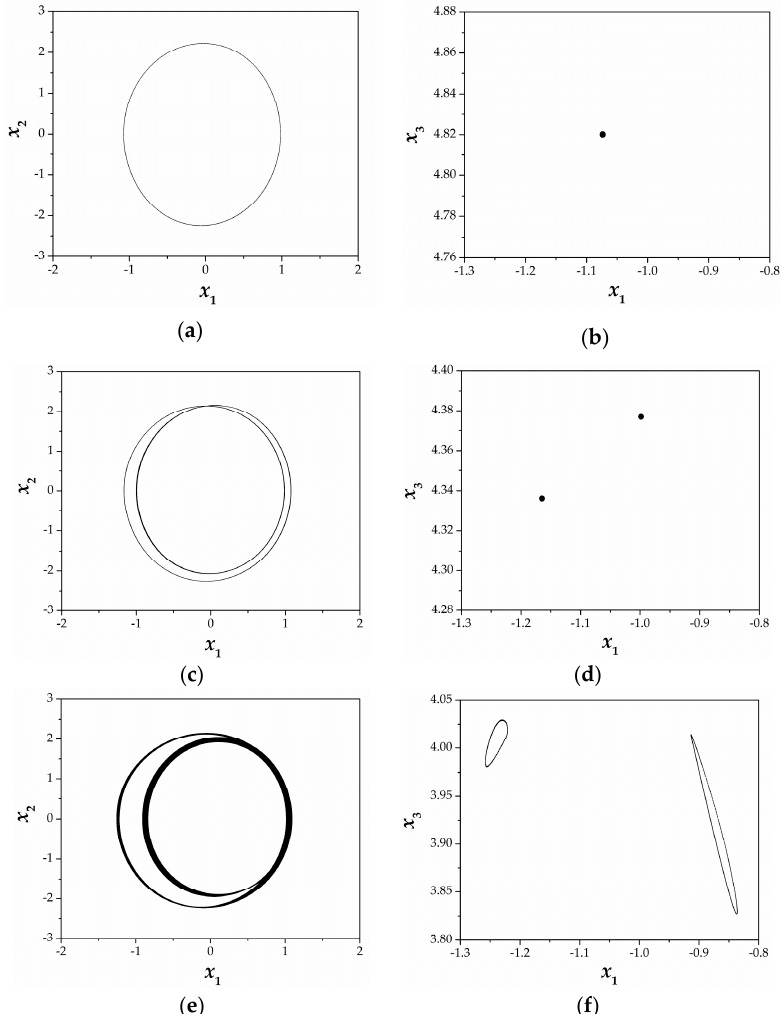
Figure 5. Phase portraits in x 1 – x 2 plane and the respective Poincaré maps in x 1 – x 3 plane, for ( a , b ) a = 5 (period-1 state); ( c , d ) a = 4.5 (period-2 state); and ( e , f ) a = 4.209 (quasiperiodic state). The rest of the parameters and initial conditions are: b = 0.1 and c = 1.5 and ( x 1 (0), x 2 (0), x 3 (0), x 4 (0)) = (0.1, 0.1, 0.1, 0.1).